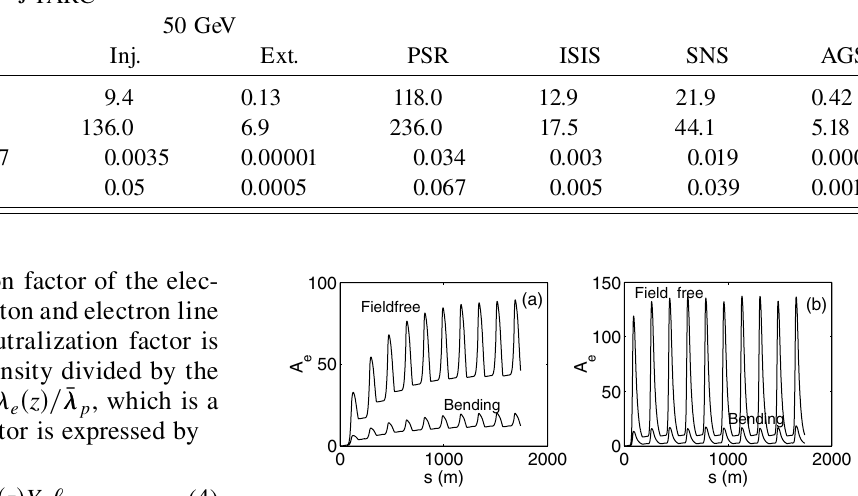
FIG. 6. Electron amplification factor in bending magnets. The amplification factors for the field-free regions are also plotted for the comparison. (a) and (b) are obtained for 3 and 50 GeV injection at J-PARC, respectively.